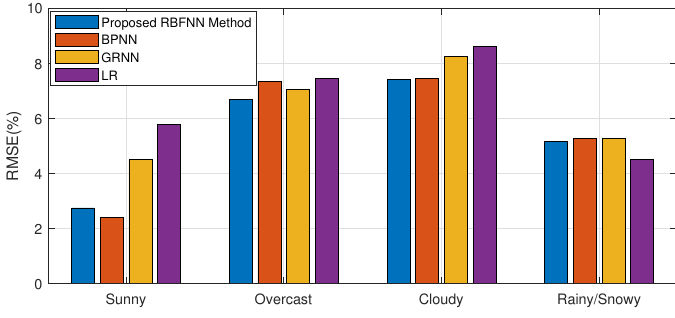
Figure 14. The RMSEs of four PV forecasting